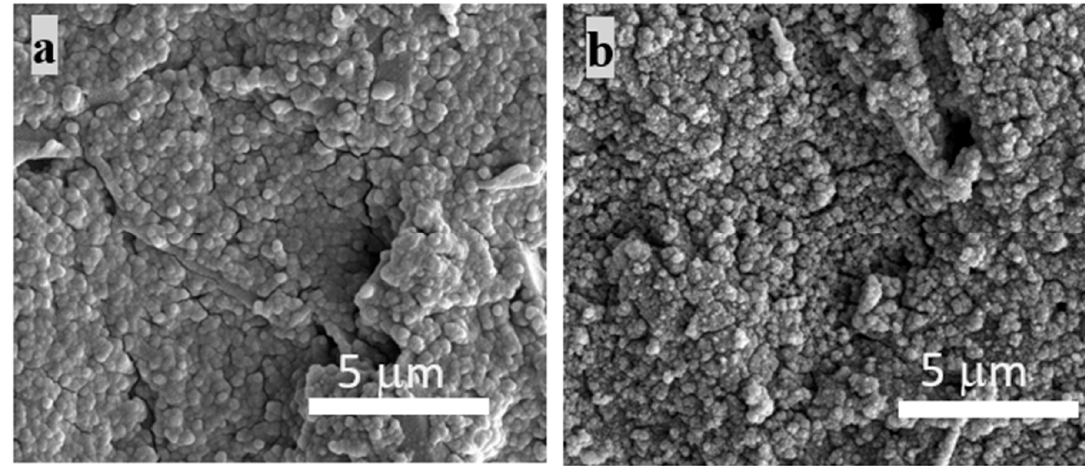
Figure 11. SEM images of one layer of PB on a screen printed carbon electrode (GCE) ( a ) before and ( b ) after exposing to •OH radicals.